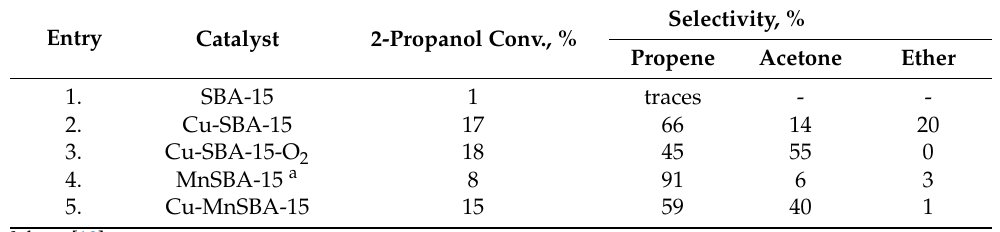
Table 4. A comparison of the results for the supports (SBA-15 and MnSBA-15–entries 1,3) indicates the generation of acid centers on the surface of silica after manganese introduction (deduced from propene formation and an increase in 2-propanol conversion from 1% to 8%). The selectivity to propene, formed on acid sites of above 90%, was achieved for this sample. For MnSBA-15 also some activity of basic centers (6% selectivity to acetone) and acid-base pairs (3% selectivity to the diisopropyl ether) was evidenced. Table 4. Results of 2-propanol decomposition at 573